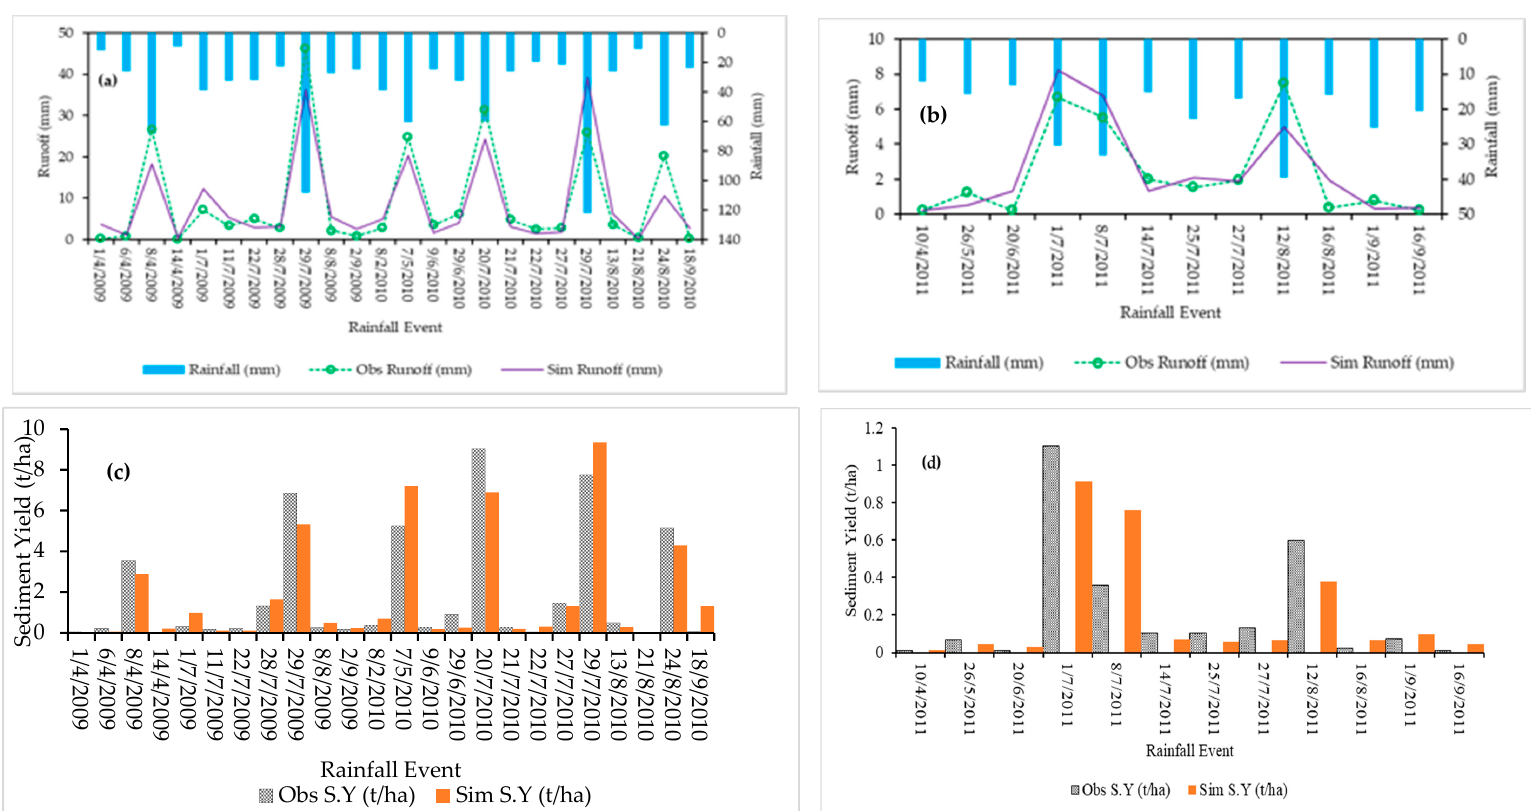
Figure 6. Soil and Water Assessment Tool (SWAT) model calibration ( a & c ) and validation ( b & d ) for surface runoff and sediment yield, respectively of Catchment-25.